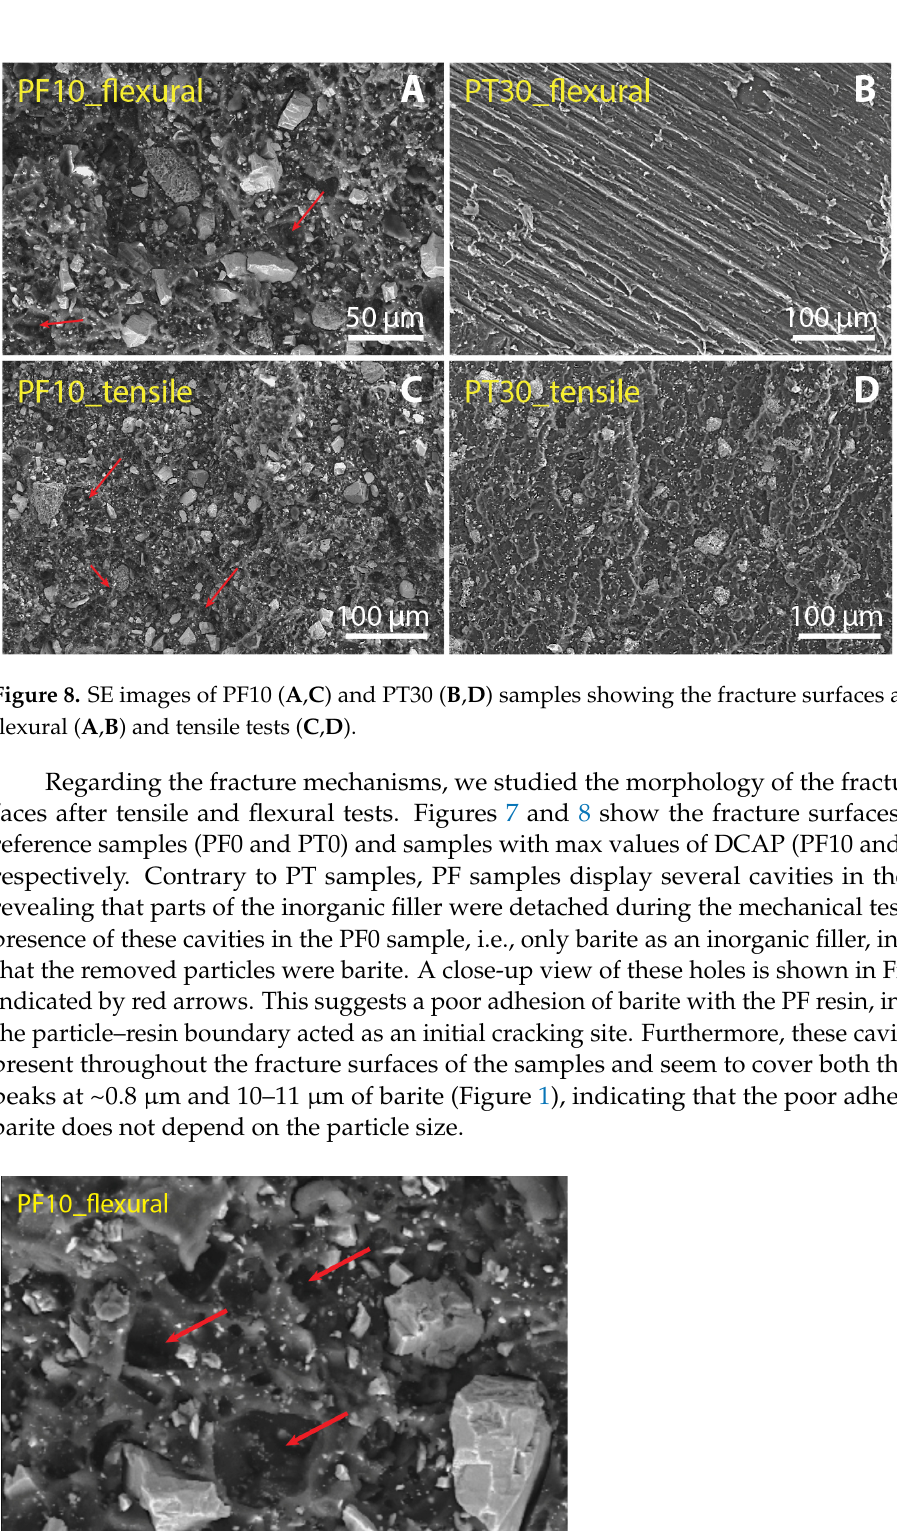
Figure 9 . SE image showing a close-up view of the holes (highlighted by red arrows) left by the removal of the microparticles of barite due to the applied force during the flexural test on